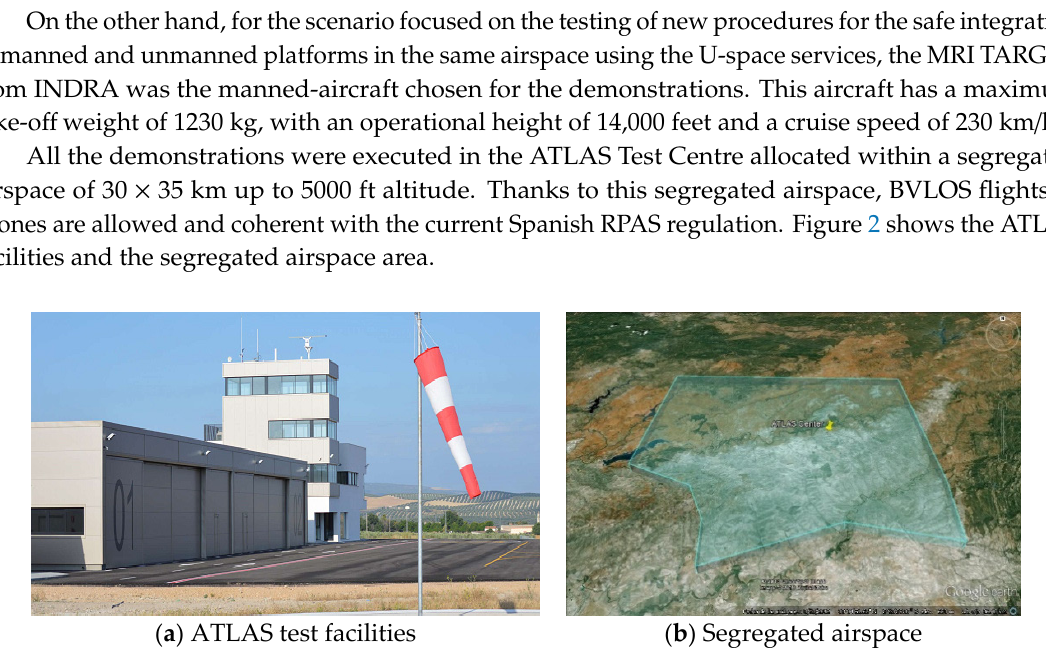
Figure 2. ATLAS test facilities located in Villacarrillo (Spain).